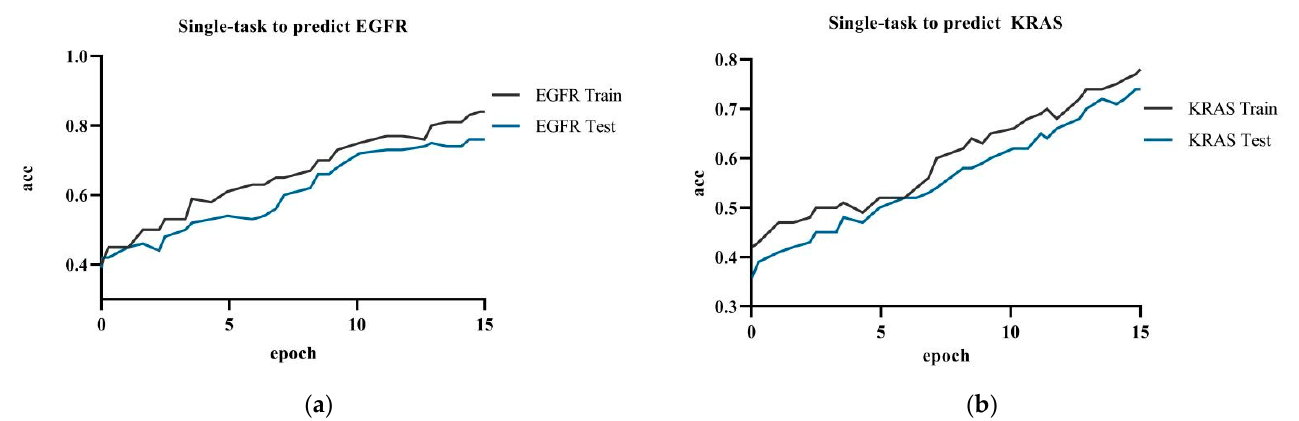
Figure 7. Experiment c: ( a ) single-task training in the ResNet network to predict EGFR gene; ( b ) single-task training in the ResNet network to predict KRAS gene.